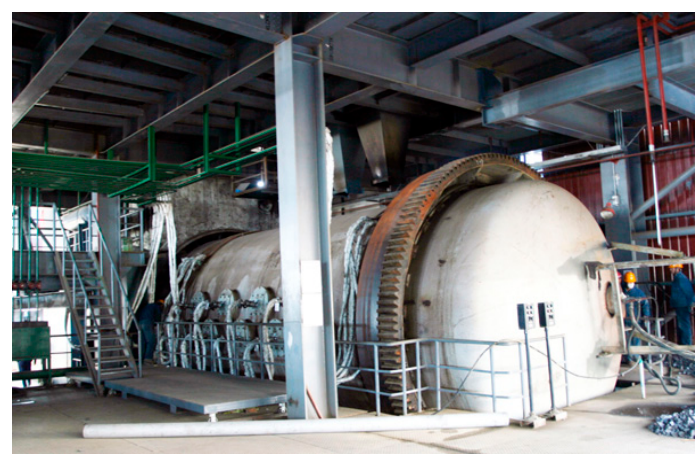
Figure 9. Commercial SKS smelting furnace in the Fangyuan 1 # phase smelter.